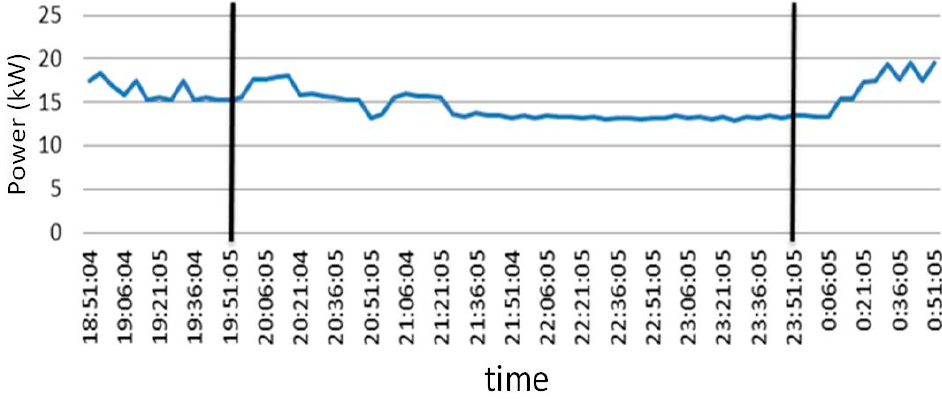
Figure 10. Total power consumption of chiller and AHU.